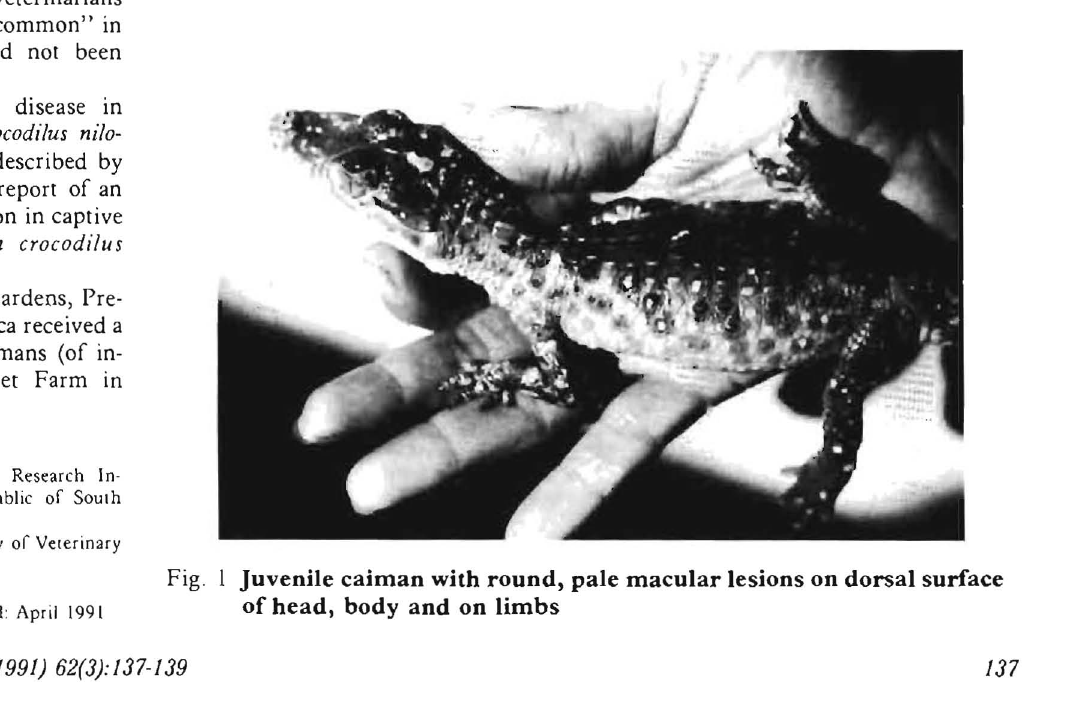
Fig. I Juvenile caiman with round, pale macular lesions on dorsal surface of head, body and on